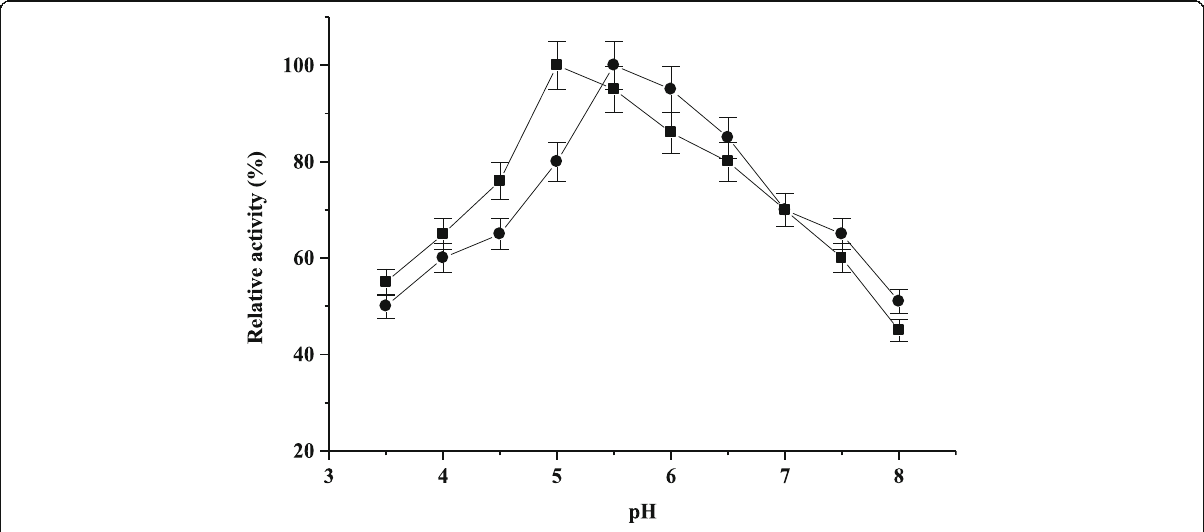
Fig. 1 Alpha-galactosidase production by Penicillium sp. (black square) at different initial pH